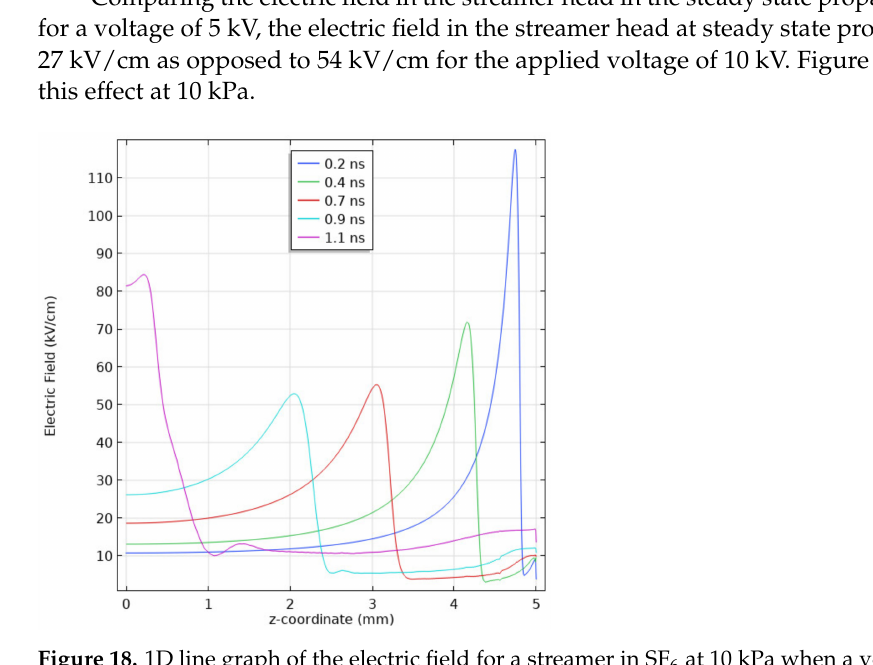
Figure 18. 1D line graph of the electric field for a streamer in SF 6 at 10 kPa when a voltage of 10 kV is